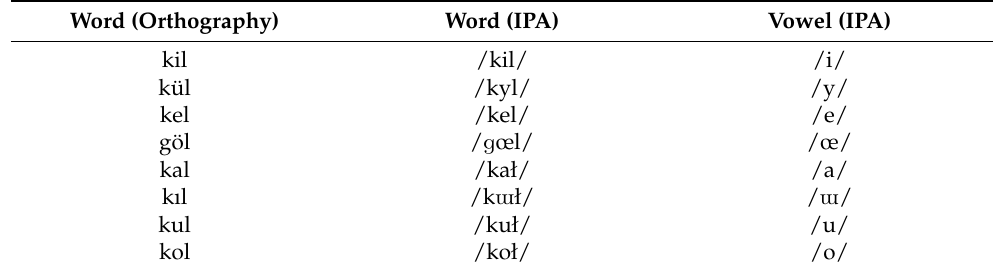
Table 2. Turkish word list with the corresponding target vowels (after Zimmer and Orgun 1992).